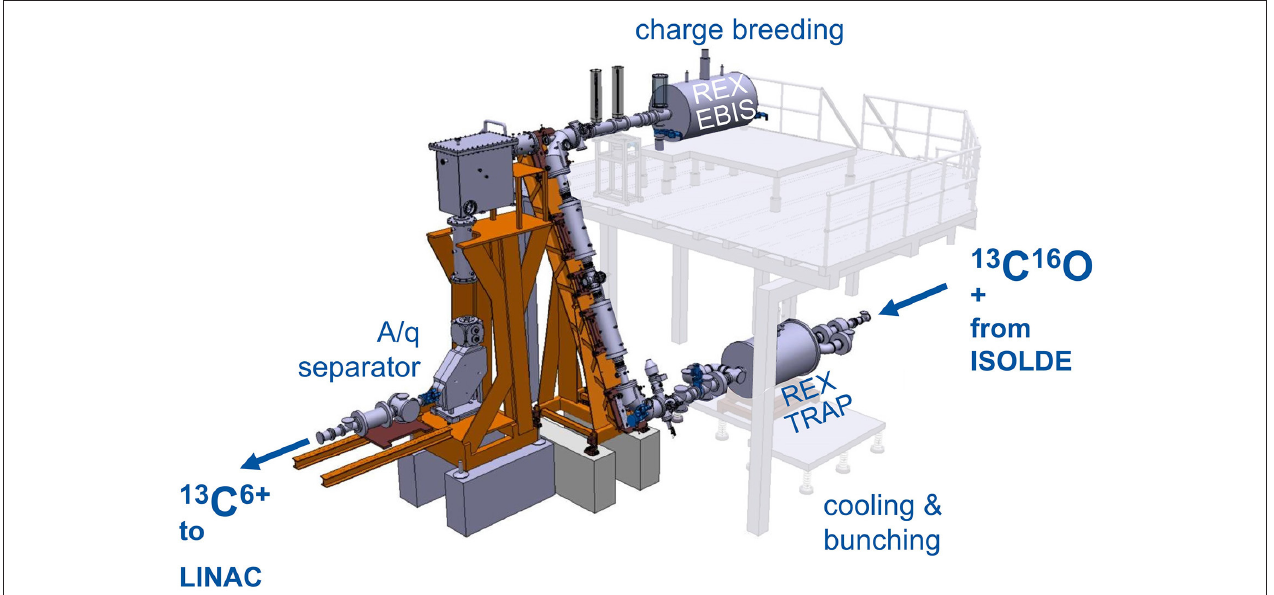
FIGURE 6 | REX-ISOLDE low energy stage, comprised of REXTRAP for cooling and bunching of the 1 + ion beam, the electrostatic beam transfer section (BTS), REXEBIS for charge breeding 1 + → N + and an A/Q separator. The charge breeder stage transforms a continuous 1 + beam into a pulsed beam of higher charge.